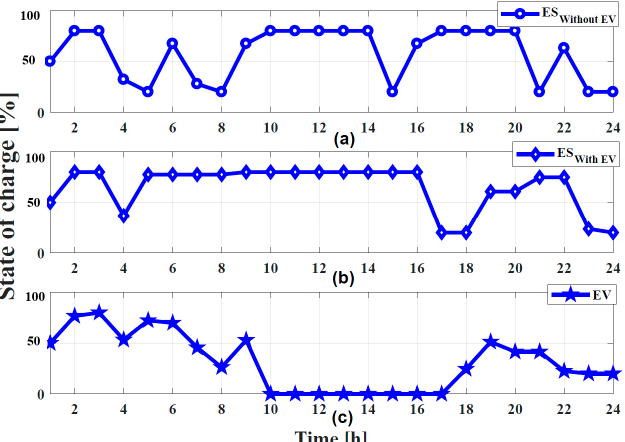
Figure 5. SoC during system daily performance. ( a ) is representing the SoC (State of Charge) of ES related to the H-MG. ( b ) is the SoC of ES, when the EV is connected to the H-MG. ( c ) is the SoC of EV in general.